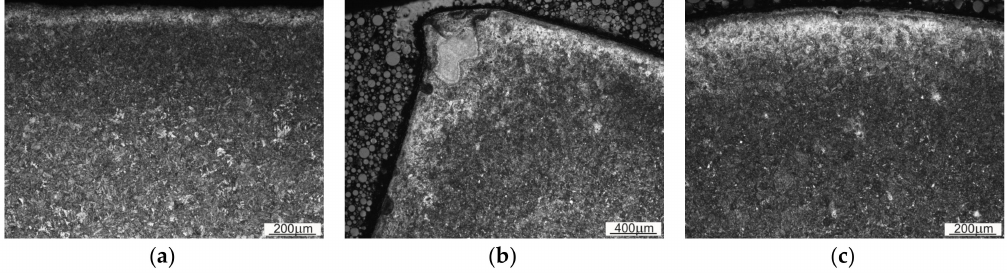
Figure 14. Microstructure within the edge area of the first row of the sample. ( a ) Side A; ( b ) Edge AB; ( c ) Point of transition between edge AB and B.